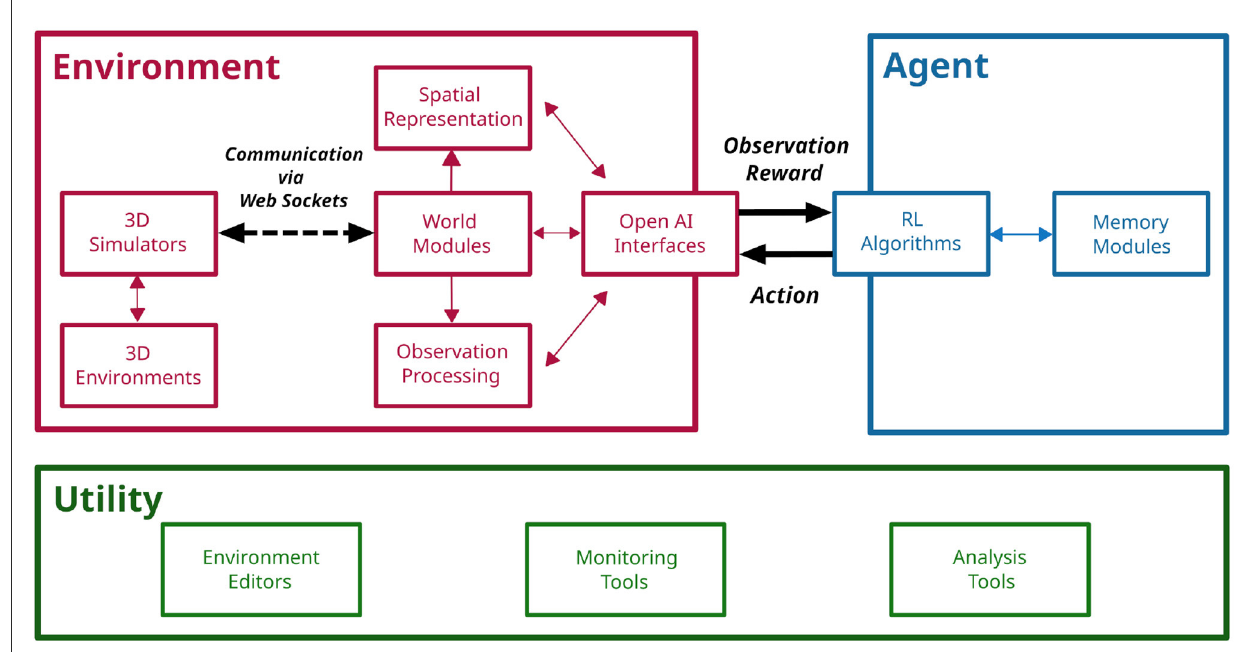
FIGURE1 The CoBeL-RL framework. Illustration of CoBeL-RL’s modules and their roles. Modules can be grouped into three categories: Modules, which handle the simulation of the virtual environment and the flow of information (Environment), implement different RL algorithms (Agent), and implement supporting functionalities (Utility) such as monitoring and data analysis. The interactions between an agent and its environment (Sutton and Barto, 2018) is implemented with the help of the module “OpenAI Interfaces” and provides observation and reward information to the agent, and sends actions to be executed to the